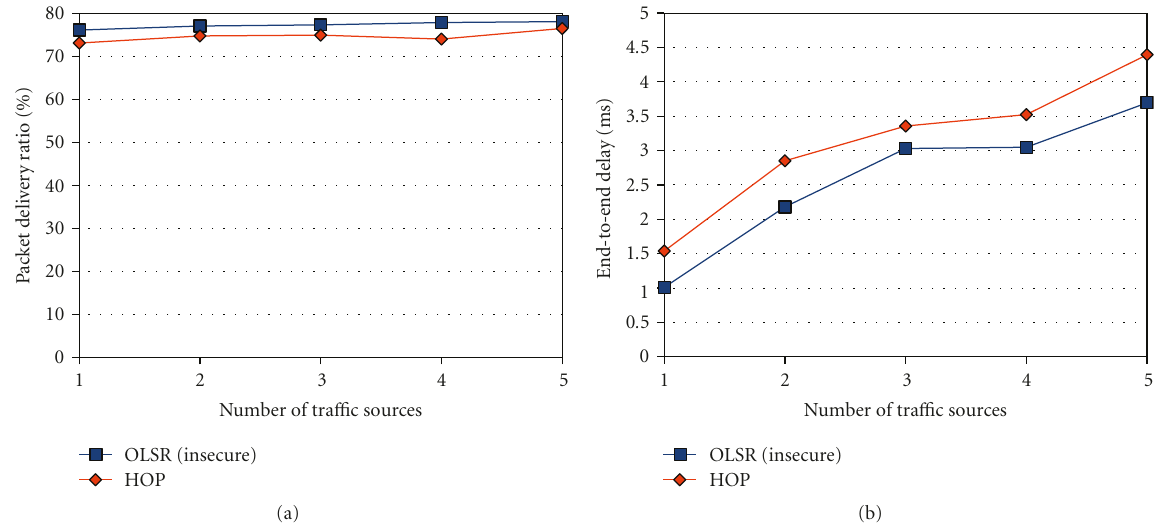
Figure 13: Packet delivery ratio (a) and end-to-end delay values (b) for OLSR and the HOP solution when increasing the aggregated load in the system.